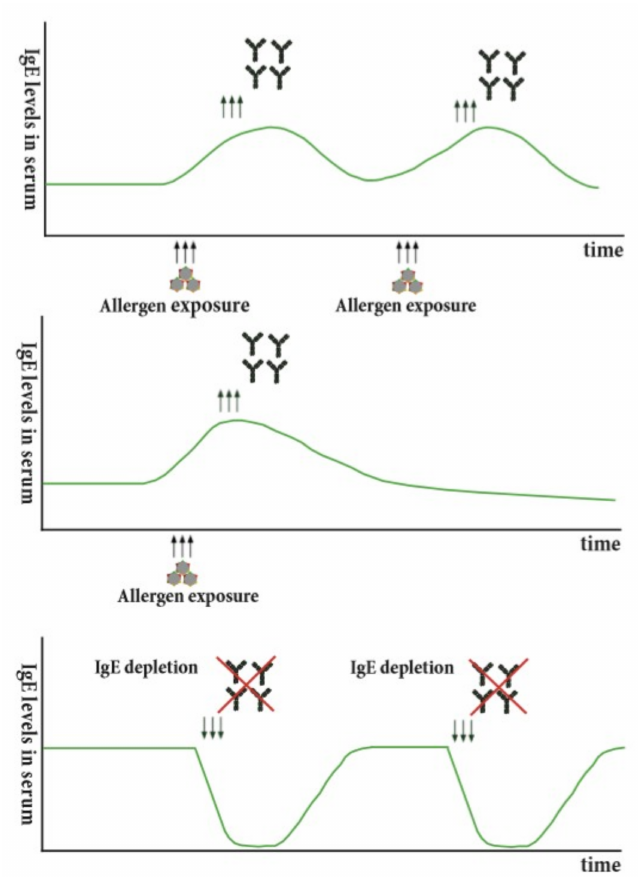
Figure 1. Potential mechanisms for maintenance of continuous IgE production. (Top) Repeated allergen exposure maintains IgE production. (Middle) Lack of allergenic stimulation leads to a slow steady decline in IgE production. (Bottom) Depletion of IgE, e.g., using IgE immune adsorption, leads only to a temporary decline of IgE levels, which subsequently return to baseline